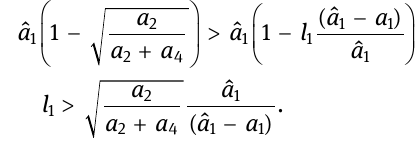
Table 1: Bibliographic source for plant parameters ( 8 ) to di ff